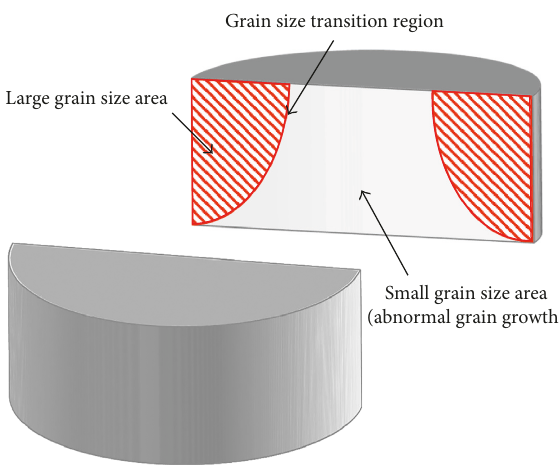
Figure 7: Schematic diagram of the sintered ZnO ceramic com- pacted by uniaxial pressing and